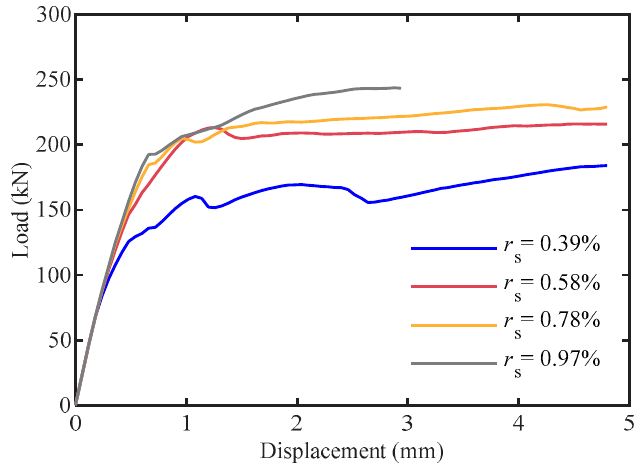
Figure 20. Influence of the reinforcement ratio of stirrups.